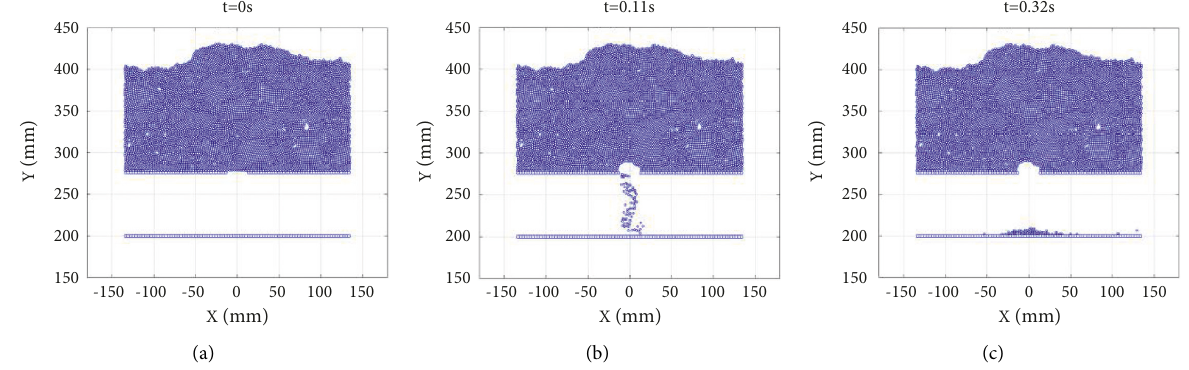
Figure 13: Snapshots of particle flow at different times. (a) t � 0s. (b) t � 0.11s. (c) t �